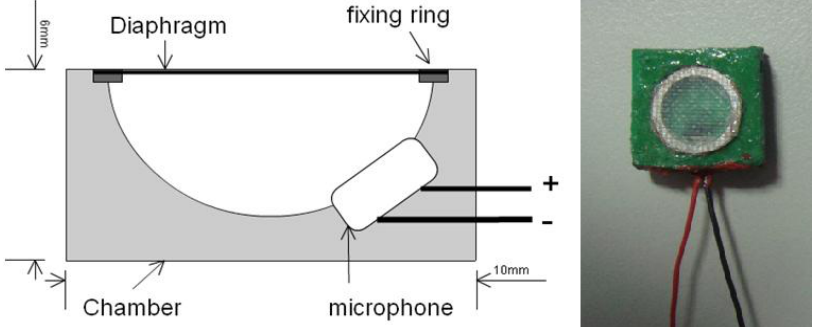
Figure 1. Structure and appearance of soft